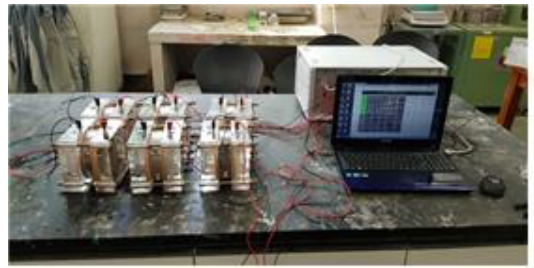
Figure 2. Photo of accelerated chloride diffusion test. 169